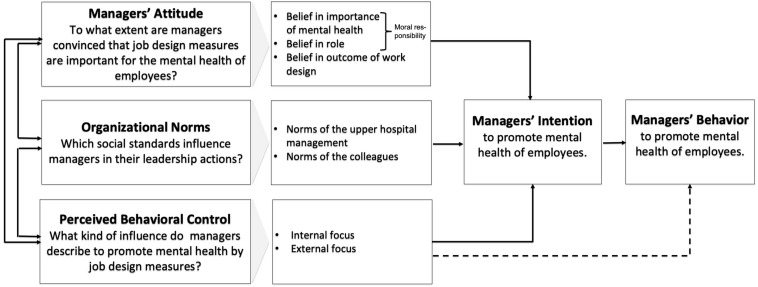
Research model based on the Theory of Planned Behavior (TPB; Ajzen, 1991).